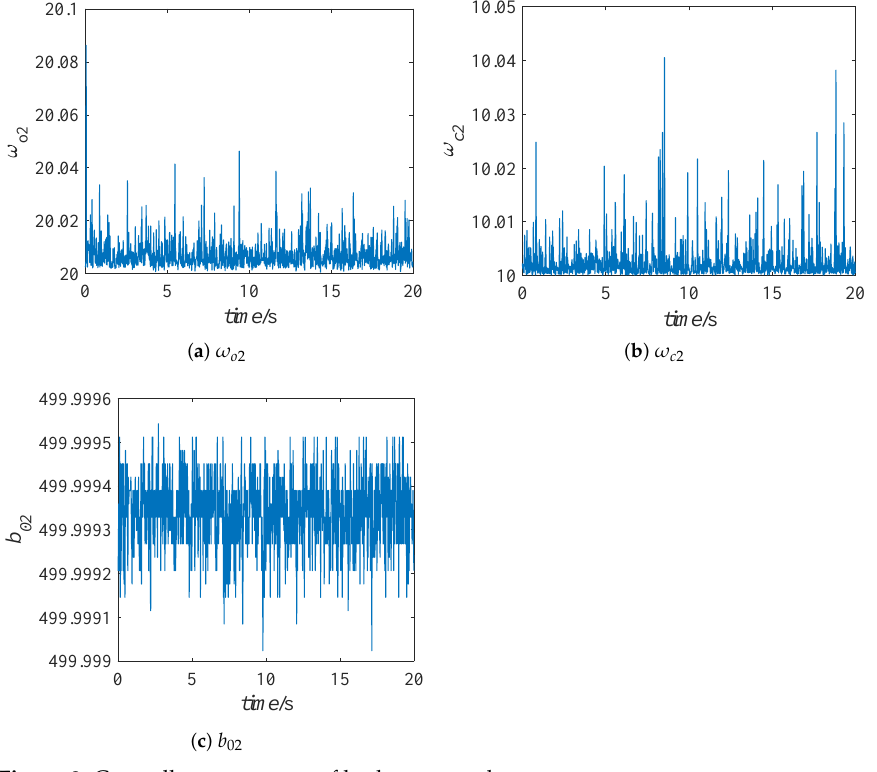
Figure 8. Controller parameters of hydropower